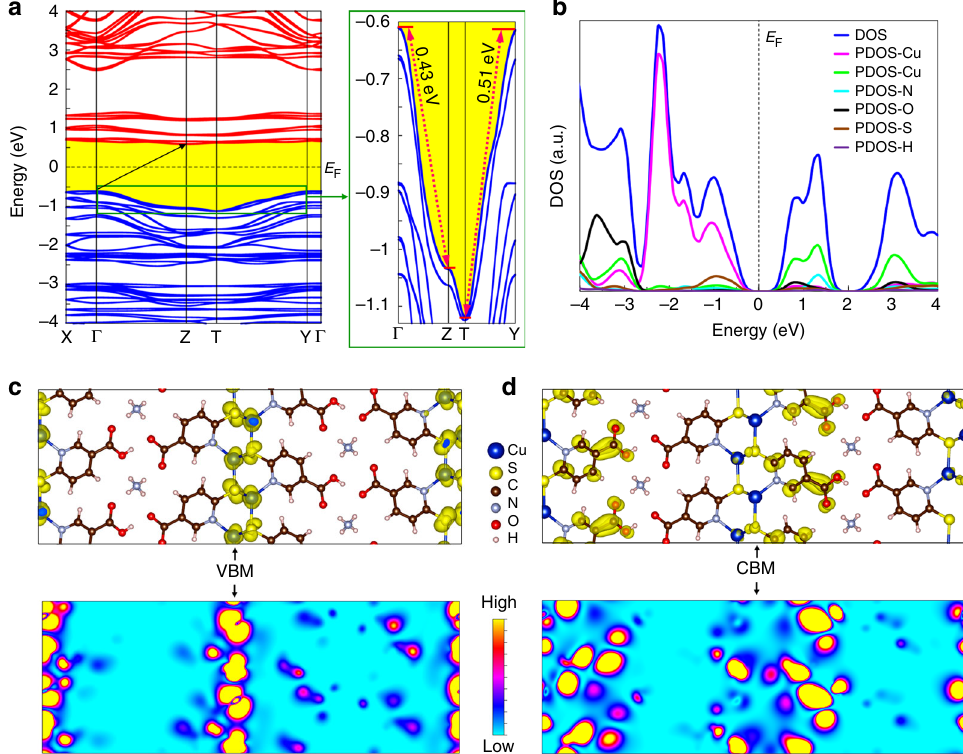
Fig. 4 Electronic structure of 1 . a Band structure. On the right of the image, an expanded plot shows the steep dispersion of the valence bands. b DOS (blue line) and the PDOS (other colored lines) of 1 . The dashed black line at zero energy represents the Fermi level ( E F ). Isosurfaces and contour plots of the band-decomposed partial charge density of c the valence band maximum (VBM) and d conduction band minimum (CBM). In combination with the PDOS, band-decomposed partial charge density plots show that the VBM is mainly composed of the states of Cu and S, and the ( – Cu – S – ) n plane generates a highly dense pathway for charge transport through